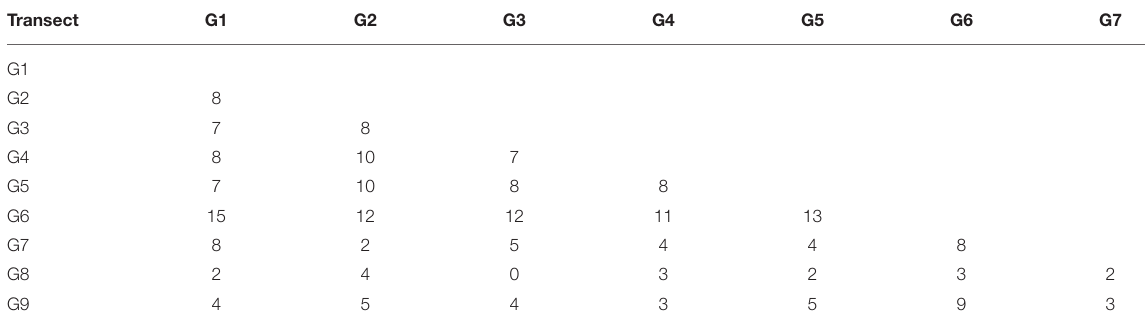
TABLE 4 | Species common between the